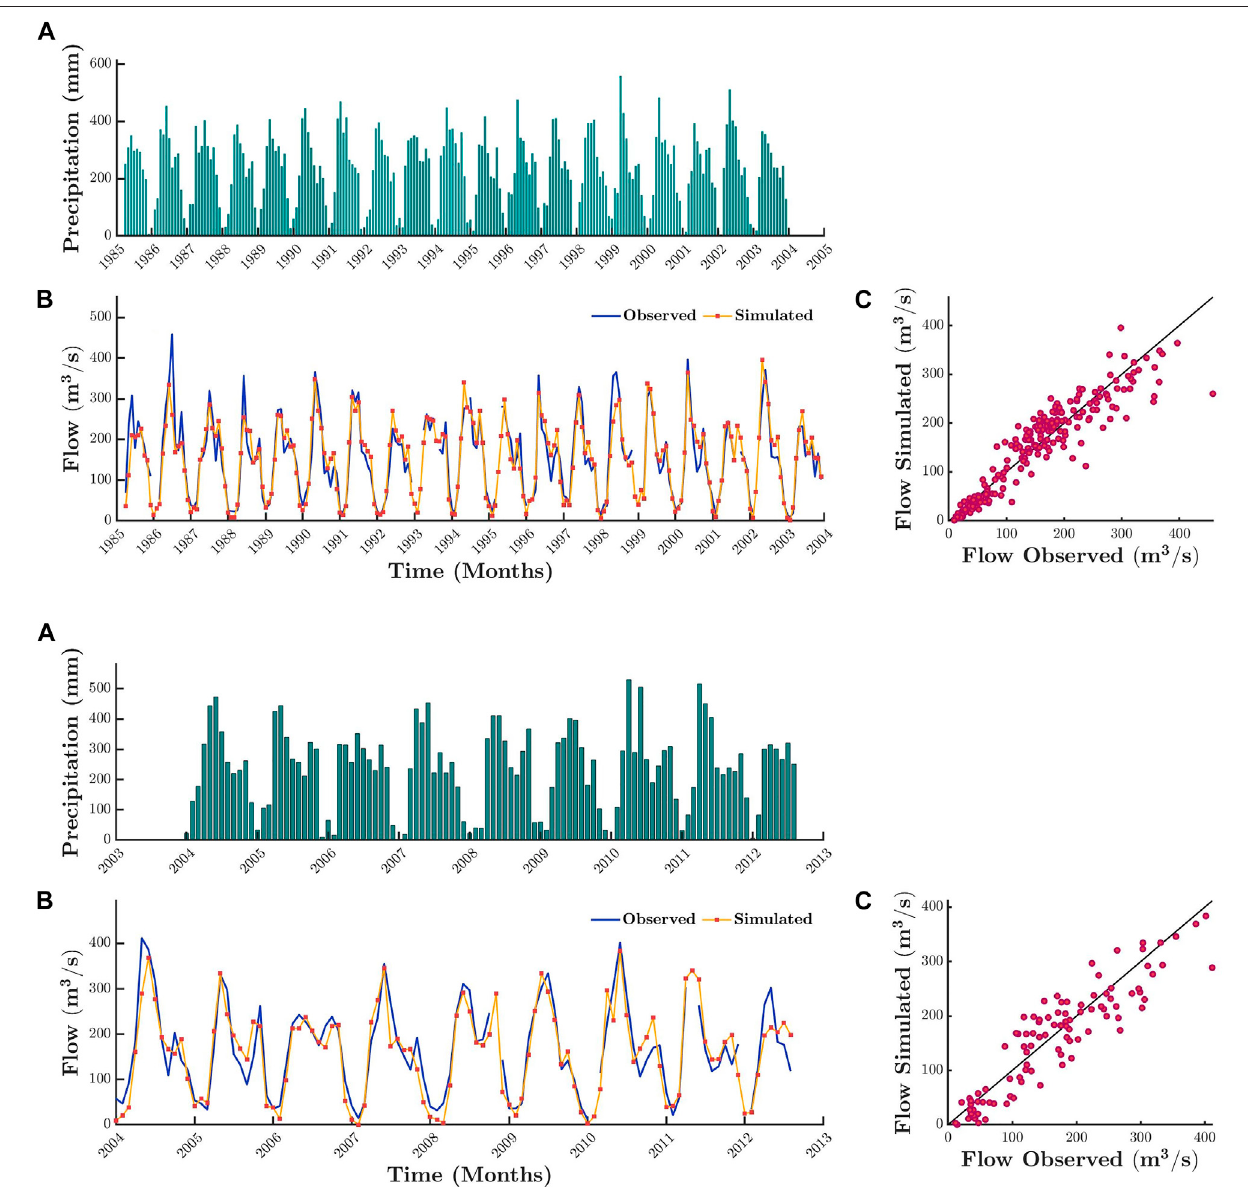
FIGURE7| Comparativegraphsinthecalibration(1)andvalidation(2)atElBarrostation[35017040]. (A) Dottyplotgraphofthevariationoftheobjectivefunctionin the evaluation range of the parameters (a is runoff, b is upper limit of evapotranspiration and soil moisture, c. is groundwater fraction, d is reciprocal of groundwater residence time, Q threshold and V threshold indicate the percentage of contribution in each of the directions of the interaction, T rf j j contribution in each of the directions of the river- fl oodplains and fl oodplains-river interaction and Ext is the percentage of water demand that is supplied by groundwater). (B) Graphsofparametricregionalsensitivity,inredtheobjectivefunctionswiththelowestperformanceofthemodel,inbluetheobjectivefunctionswiththe highest performance of the model. (C) Uncertainty using the Generalized Likelihood Uncertainty Estimation method (Beven & Binley,